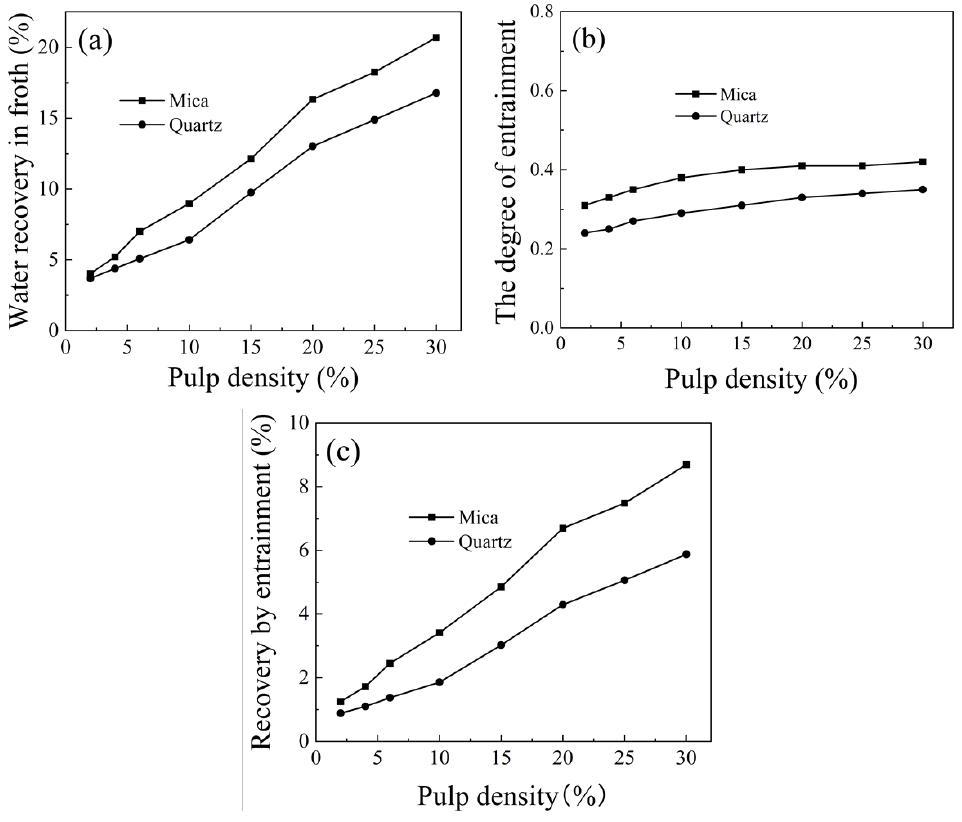
Figure 7. The effect of pulp density on ( a ) the water recovery in froth, ( b ) the degree of entrainment, and ( c ) the recovery of gangue minerals by entrainment.